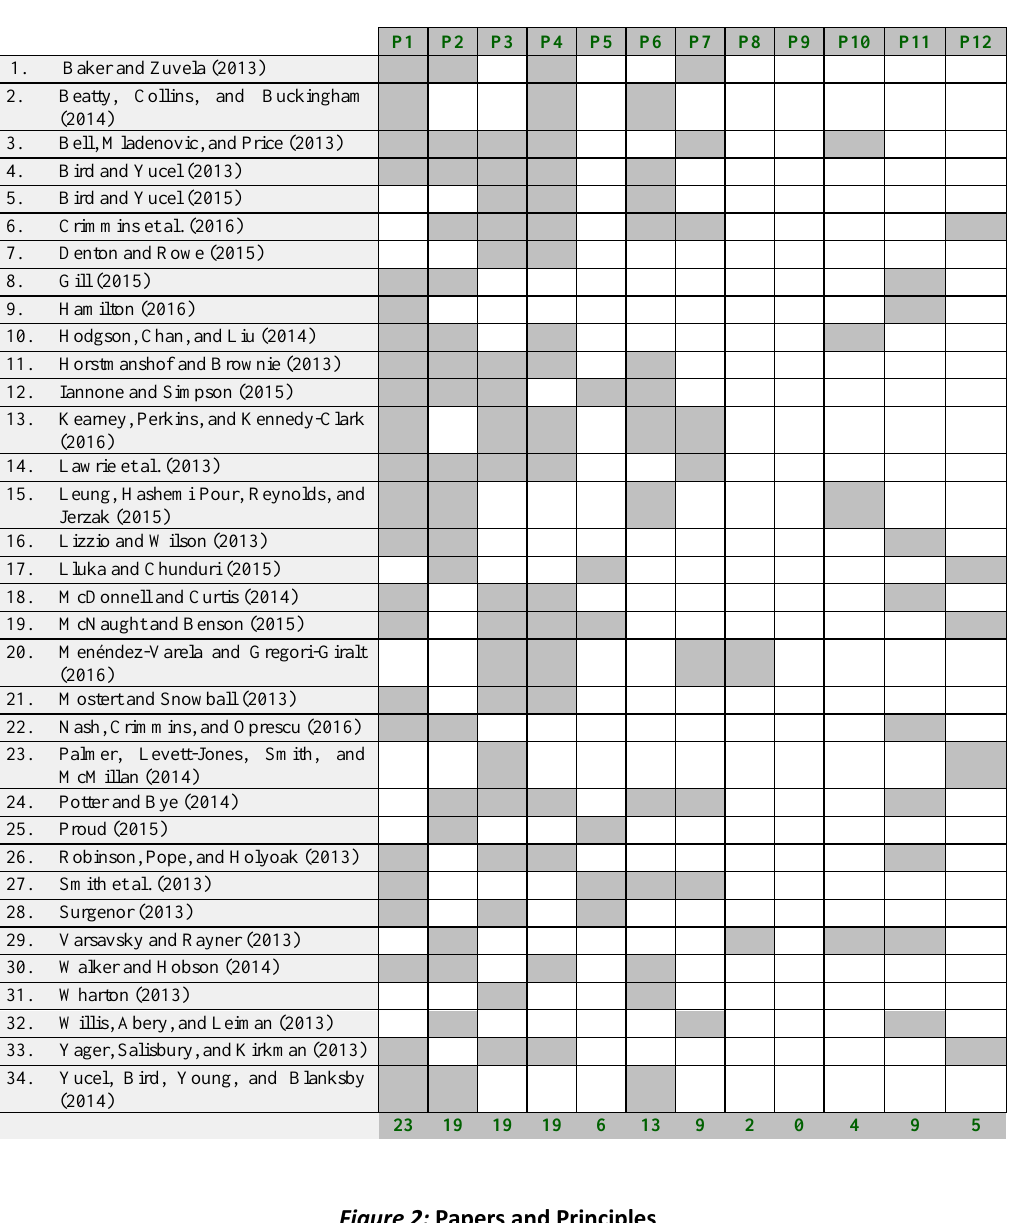
Figure 2: Papers and